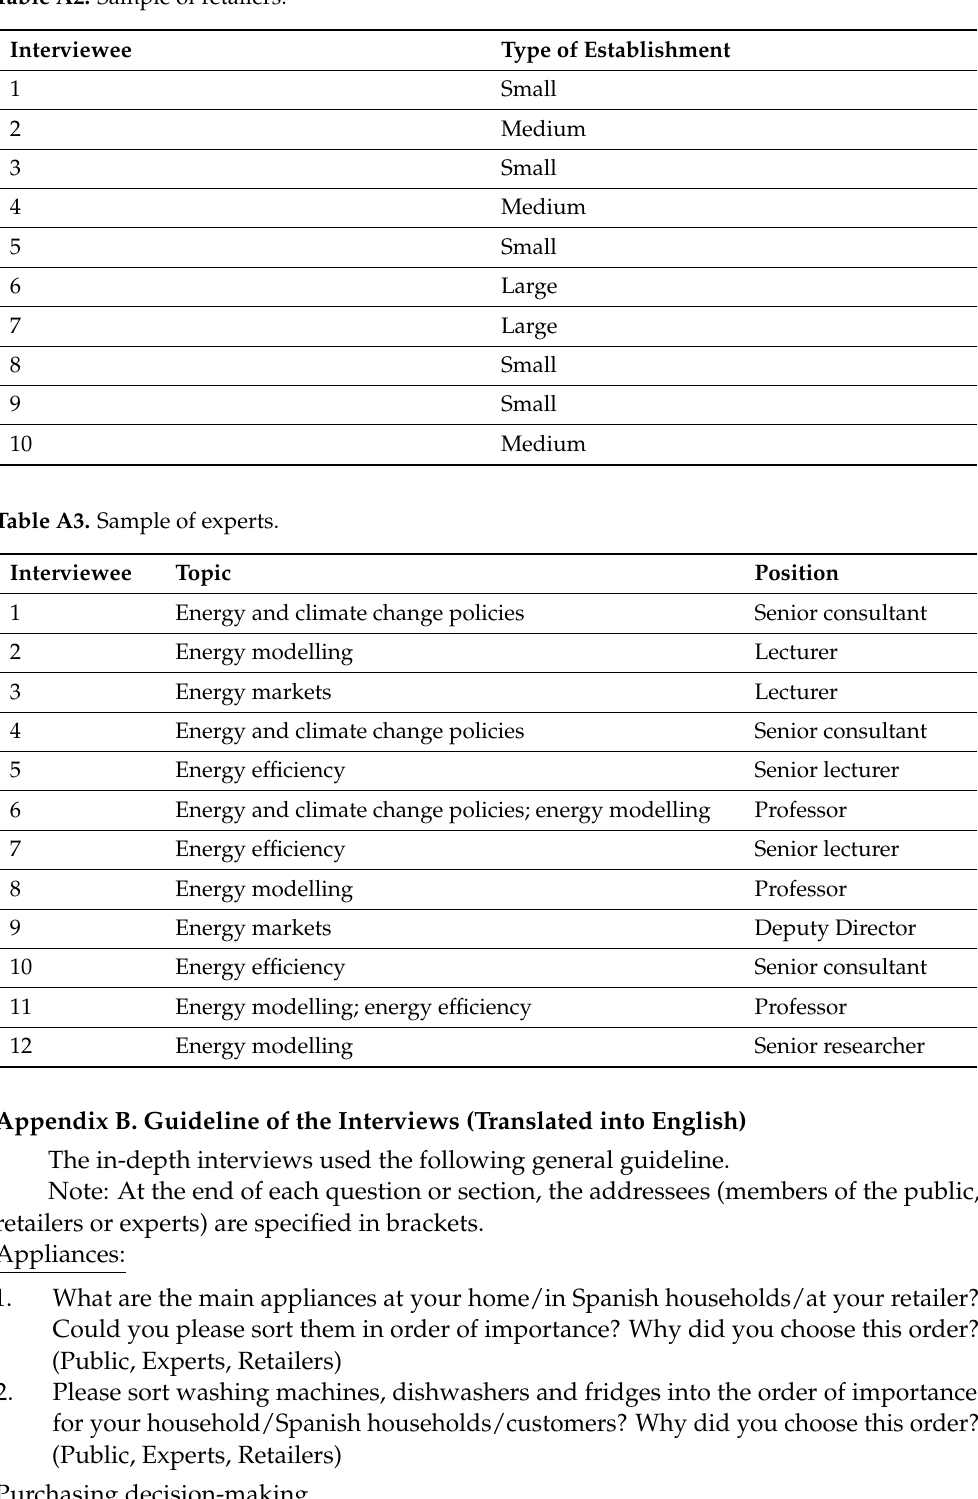
Table A2. Sample of retailers.